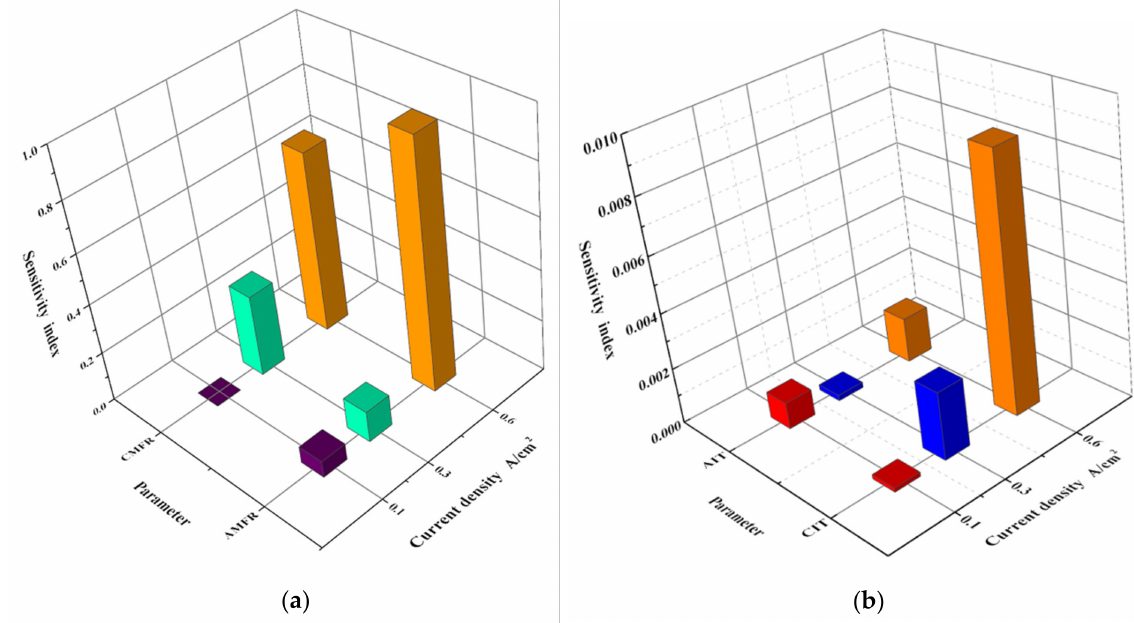
Figure 11. Sensitivity indexes of part of parameters under different current densities: ( a ) Sensitivity indexes comparison between CMFR and AMFR, ( b ) Sensitivity indexes comparison between AIT and